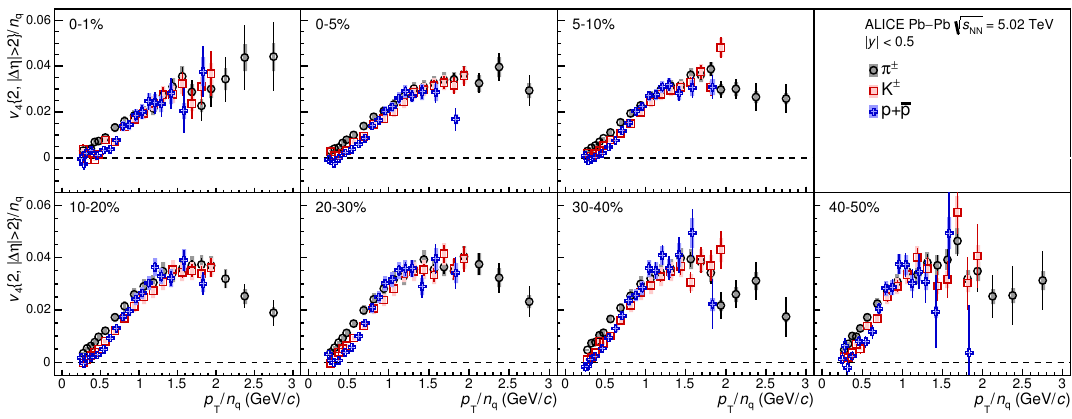
Figure 11 . (Colour online) The p T =n q dependence of v 4 =n q of (cid:25) (cid:6) , K (cid:6) , and p+p for various centrality classes. Statistical and systematic uncertainties are shown as bars and boxes,